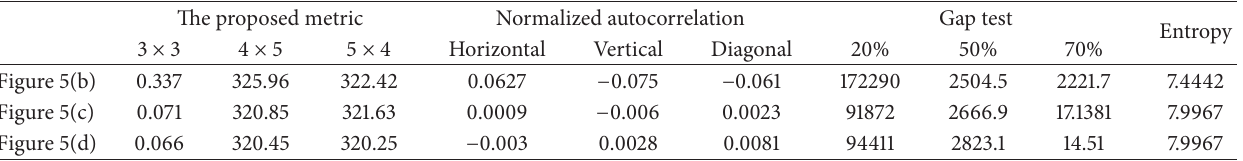
Table 8: Evaluation results of the cipher text image in Figure